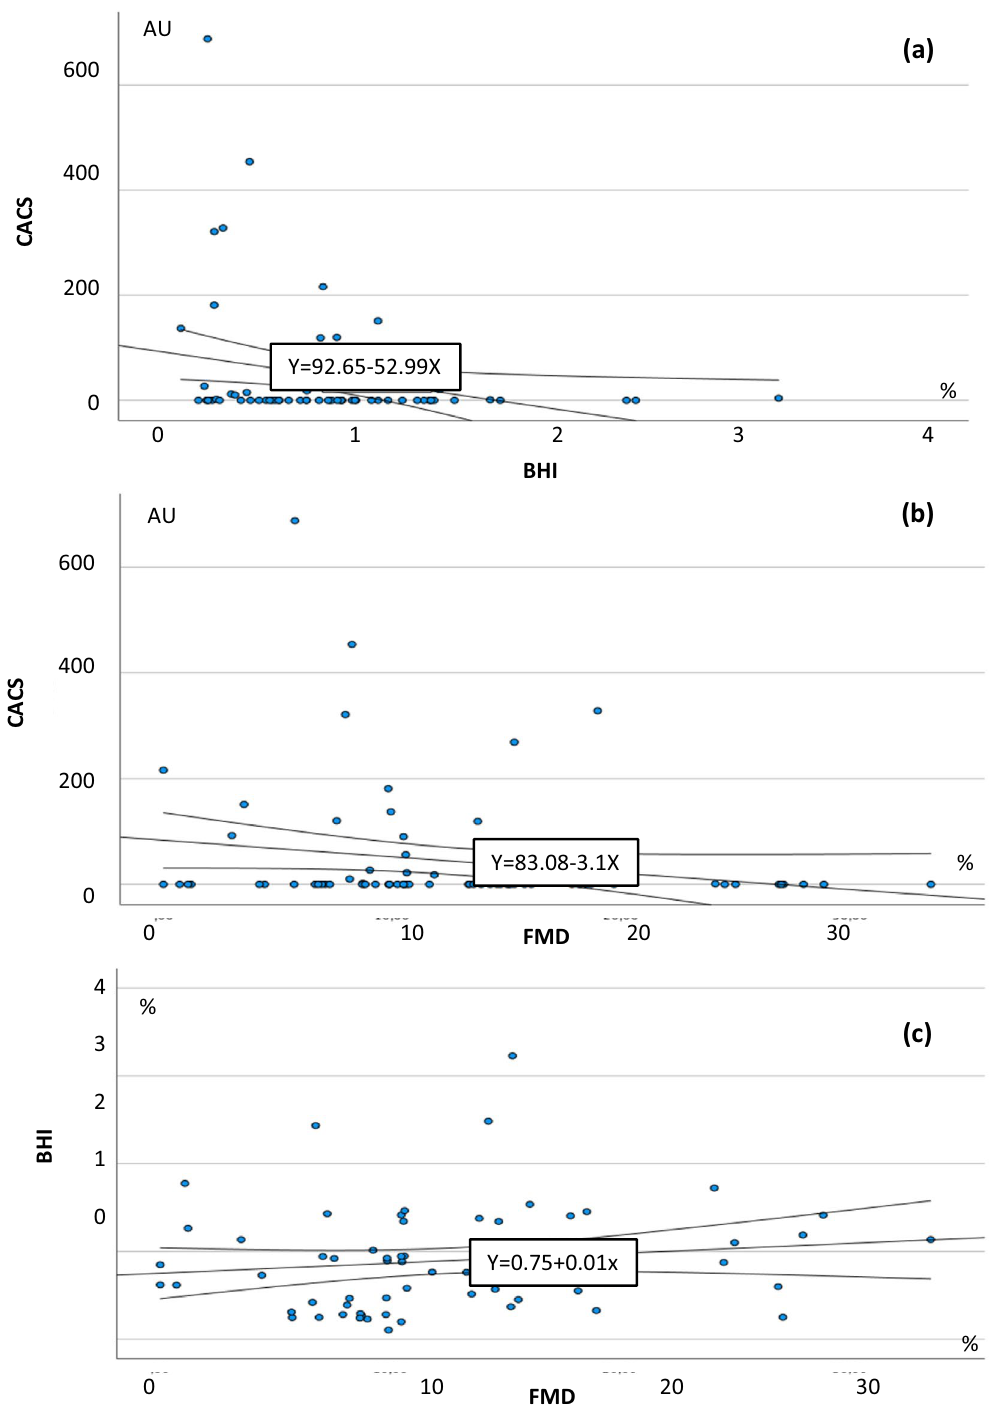
Figure 3. Correlation between CACs and the endothelial dysfunction test. ( a ) CACs versus IHC scatter plots with linear 95% CI adjustment. ( b ) CACs versus FMD scatter plots with linear 95% CI adjustment. ( c ) BHI versus FMD scatter plots with linear 95% CI